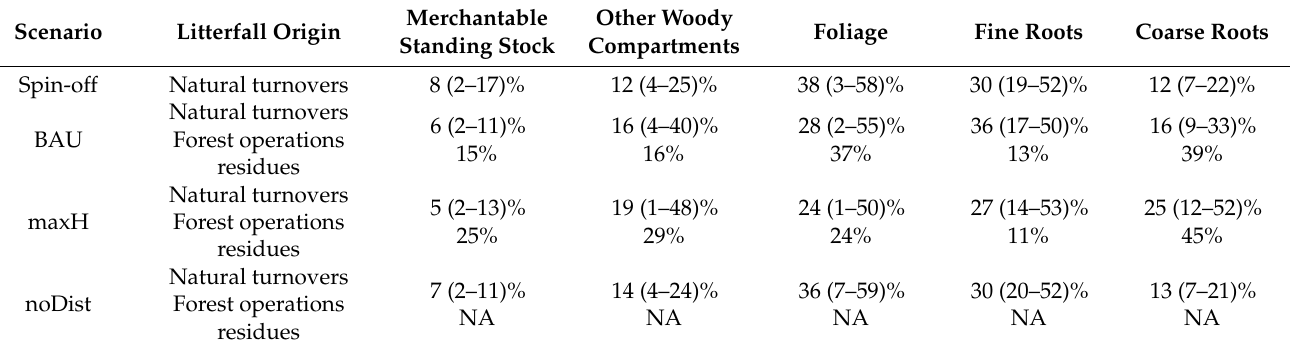
Table 4. Contribution to litterfall from natural processes (i.e., consequence of natural turnovers of the biomass compartments) and from forest residues (from silvicultural operations) in the spin-off (initialization) and for the simulation of the three scenarios. NA applies for residues from forest operations in noDist scenario.